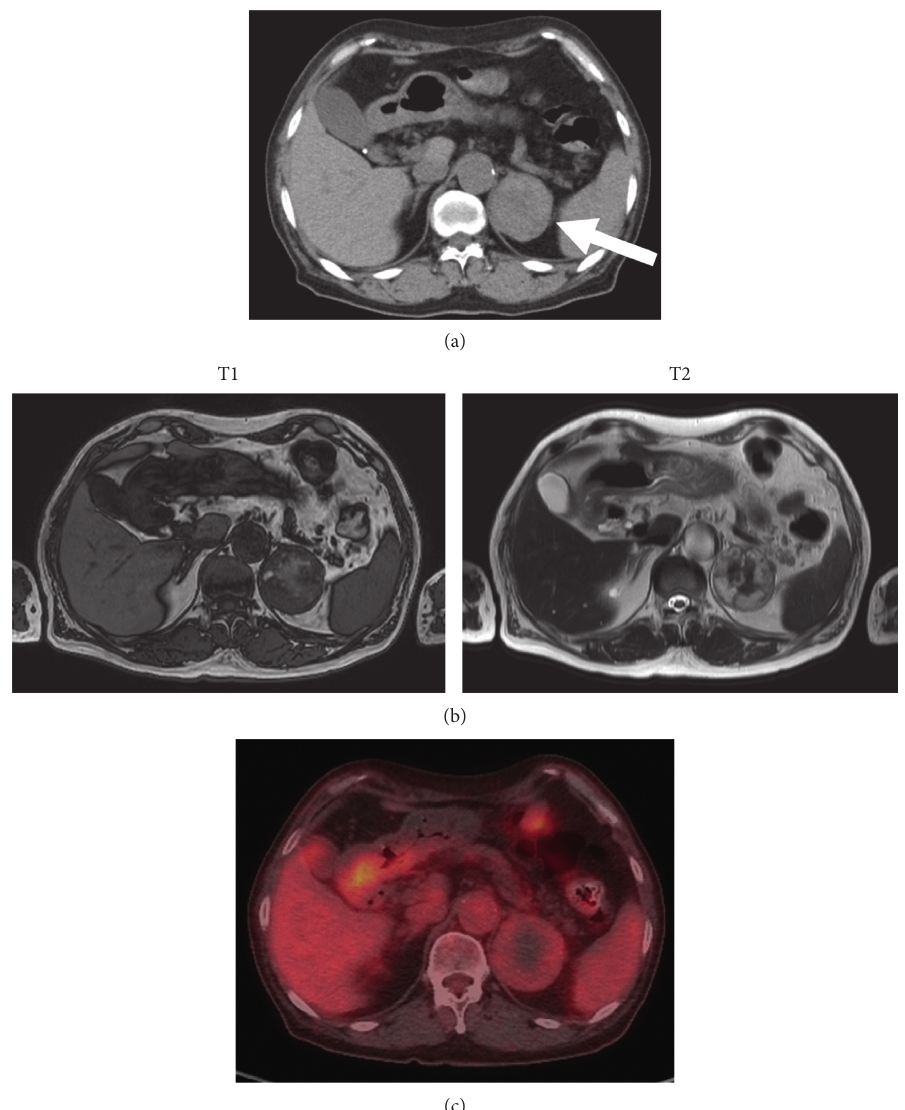
Figure 1: (a) Abdominal plain CT. Arrow: left adrenal mass (52mm × 50mm). (b) T1-weighed (left) and T2-weighed (right) images of plain MRI. (c)